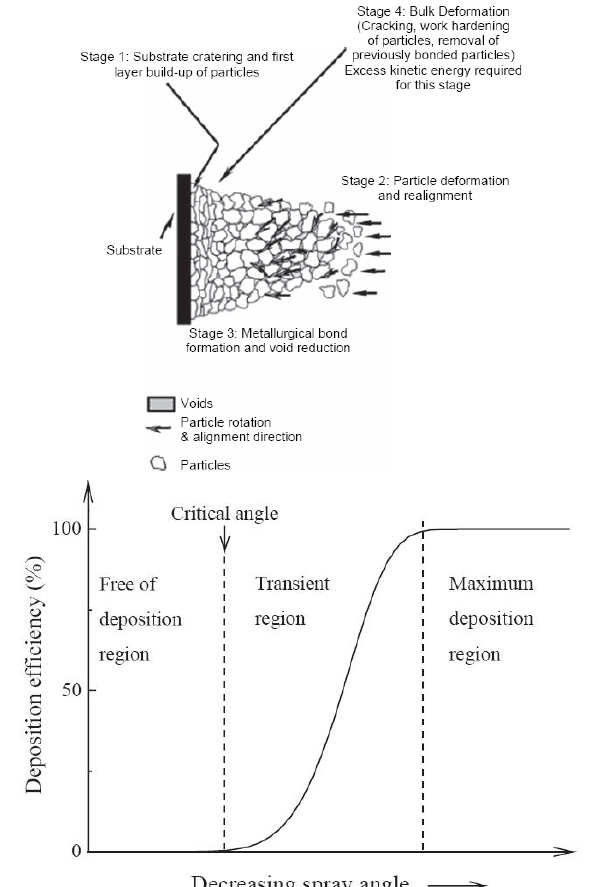
Figure 3: The schematic view of different region of particles on substrate